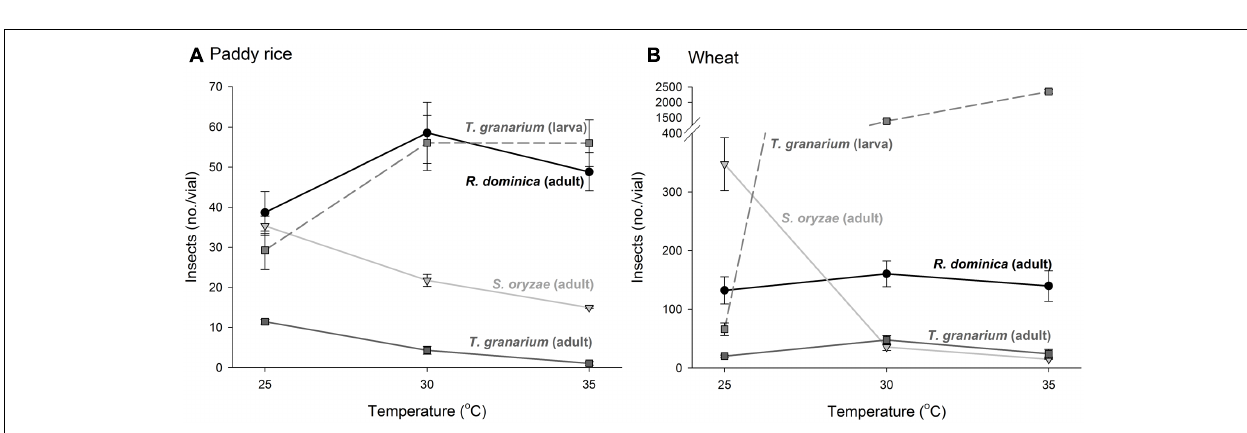
FIGURE 2 | Insect population from single-species experiment at three temperature conditions in grains of two cereal host species. Paddy rice (A) and wheat (B) . The symbols indicate the average of nine replicates and the vertical bars represent standard errors of the